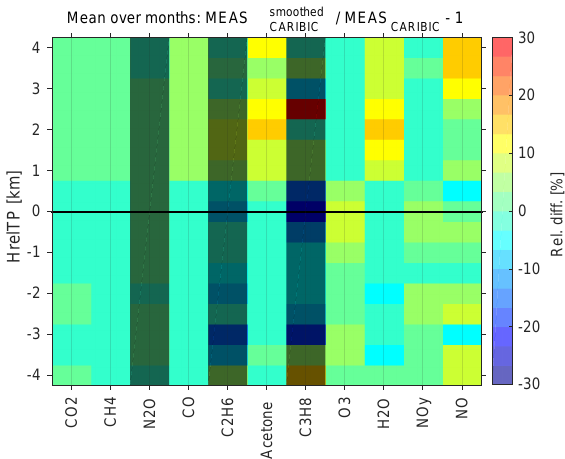
Figure 5. Mean relative differences of MEAS smoothed and CARIBIC MEAS CARIBIC . MEAS smoothed has been smoothed by interpolat- CARIBIC ing between the 20min mean values, the exact method being pre- sented in Appendix B. The relative differences correspond to the error in the climatologies of MOD sampled due to the coarse model CARIBIC resolution. N 2 O, C 2 H 6 and C 3 H 8 are measured by air samples with a low measurement frequency and are therefore not considered here.